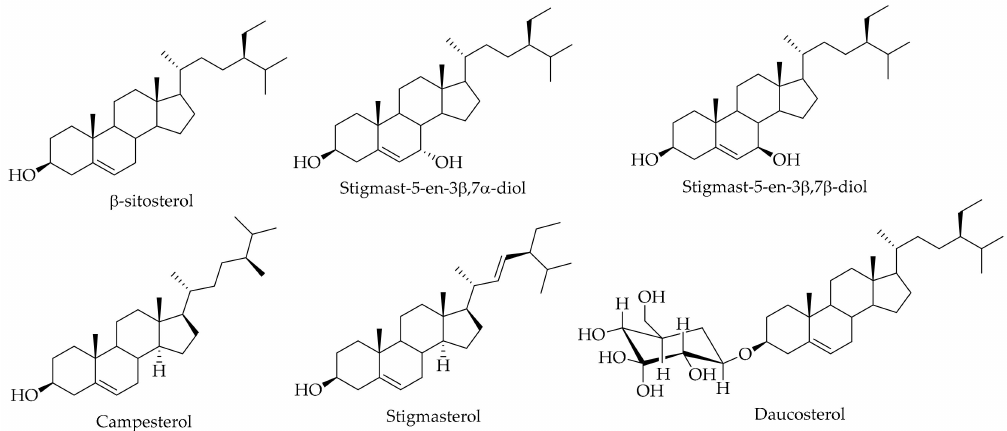
Figure 12. The chemical structures of di ff erent identified and isolated steroids in the green husk of